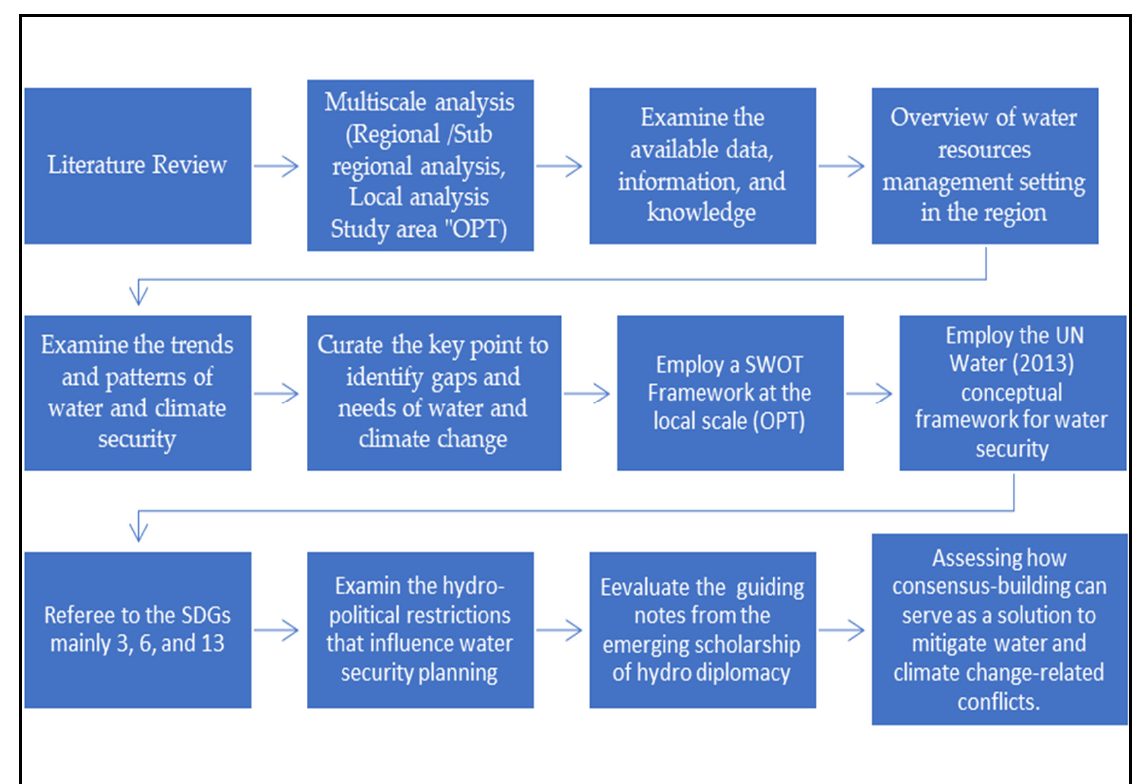
Figure 2. Summary of methodological pathway applied in this synthesis to assess and analyze the water security and climate change setting at regional, national, and subnational levels.